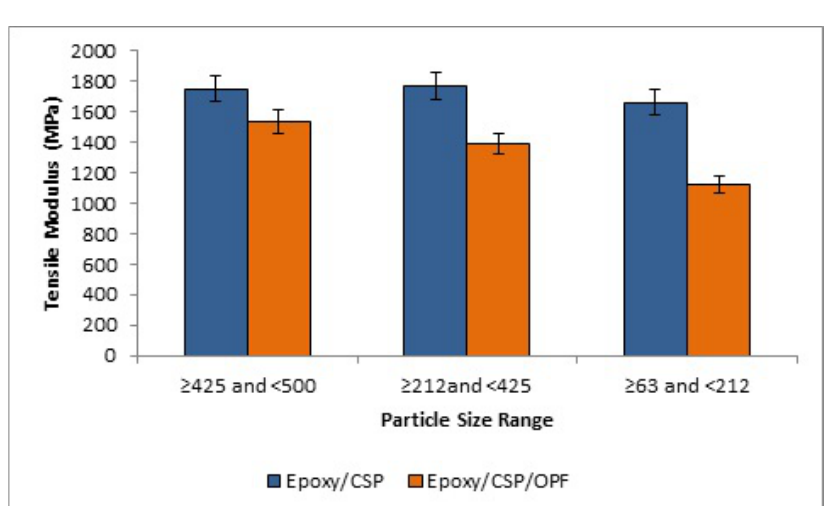
Figure 8: Tensile modulus of epoxy